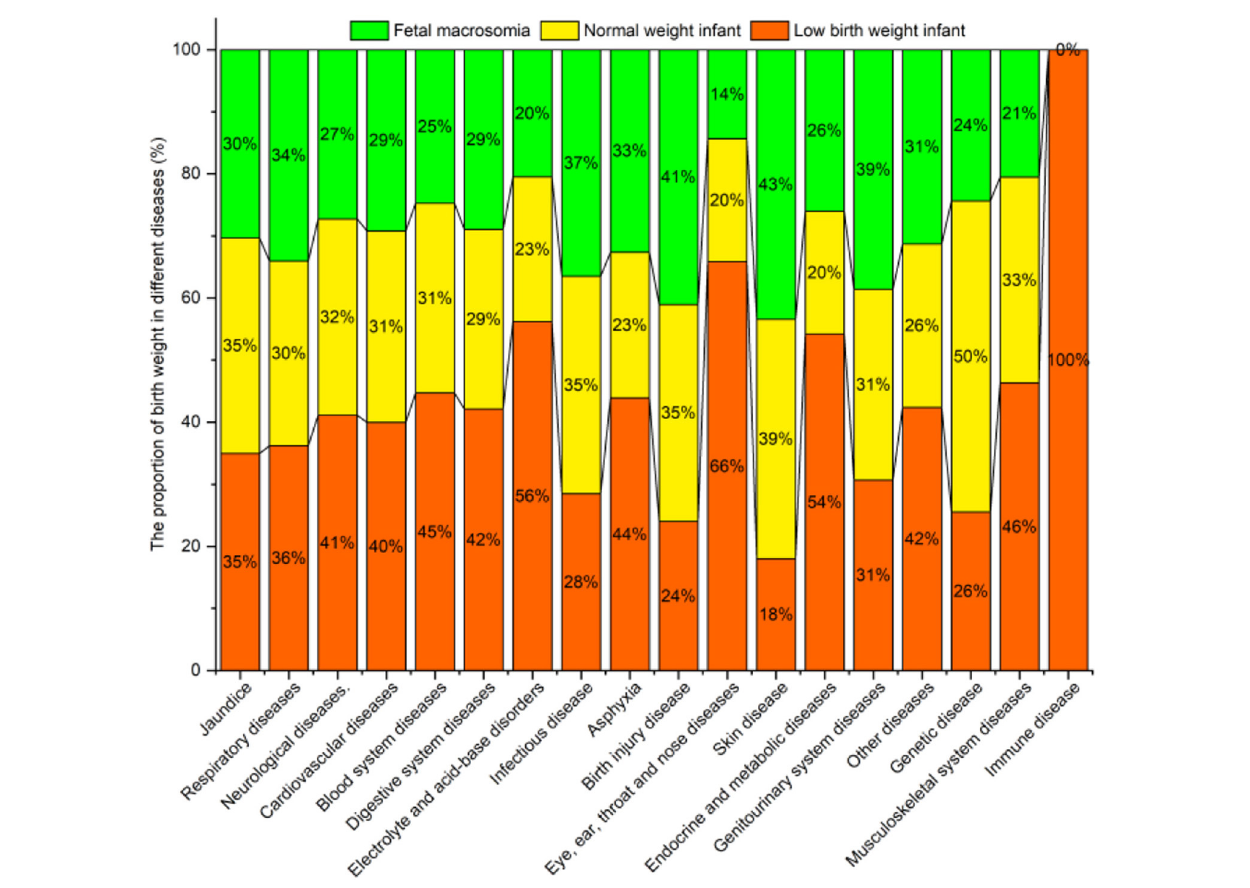
FIGURE 11 | Neonatal diseases and distribution by birth